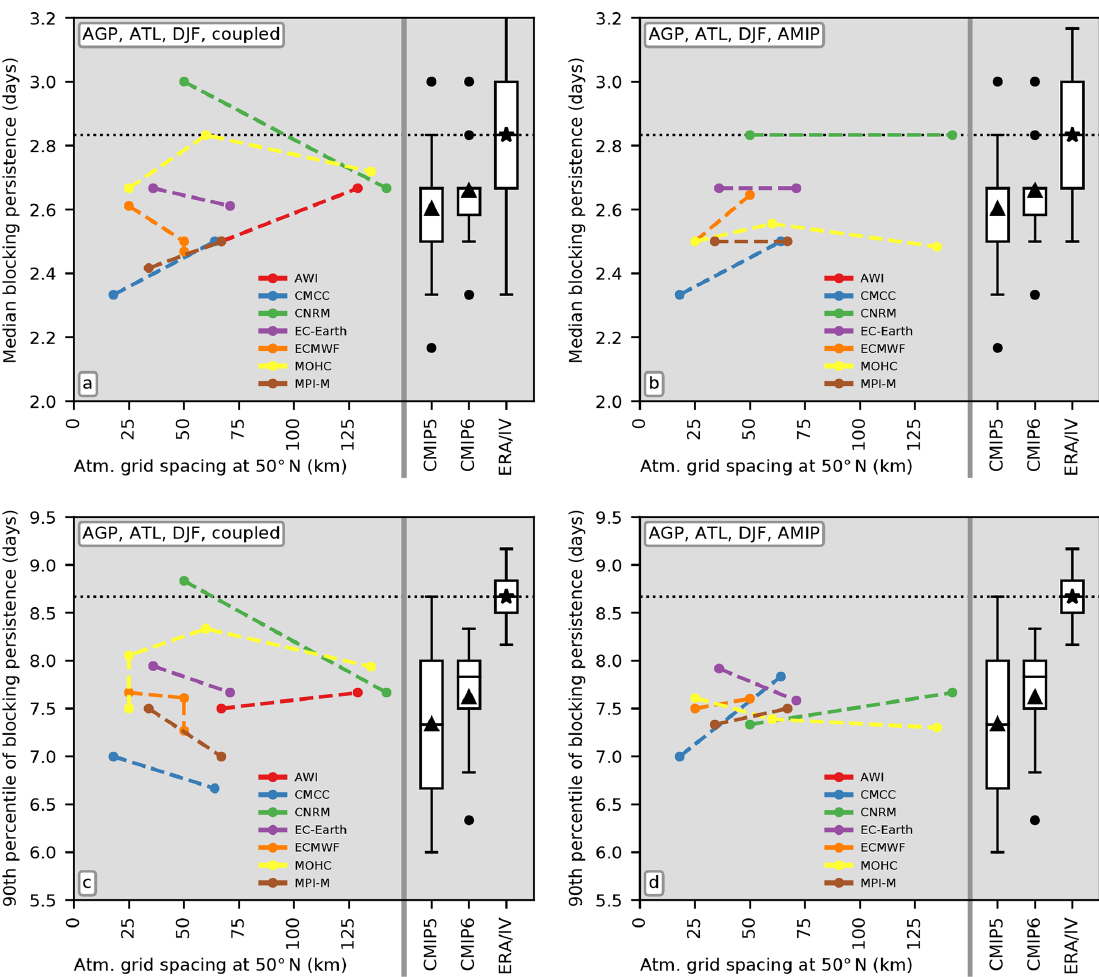
Figure 5. Persistence of blocking events ( a, b – median, c, d – 90th percentile) for the AGP index and boreal winter and for the ATL domain (50–75 ◦ N, − 90–90 ◦ E). The left-hand side of each panel shows metrics for PRIMAVERA simulations at different grid spacings (resolutions). Boxplots on the right-hand side show distributions of the persistence metric across CMIP5 and CMIP6 simulations. The “ ∗ ” symbol in the column “ERA/IV” shows the reanalysis estimate, and the boxplot is an estimate of the expected agreement given internal variability (see